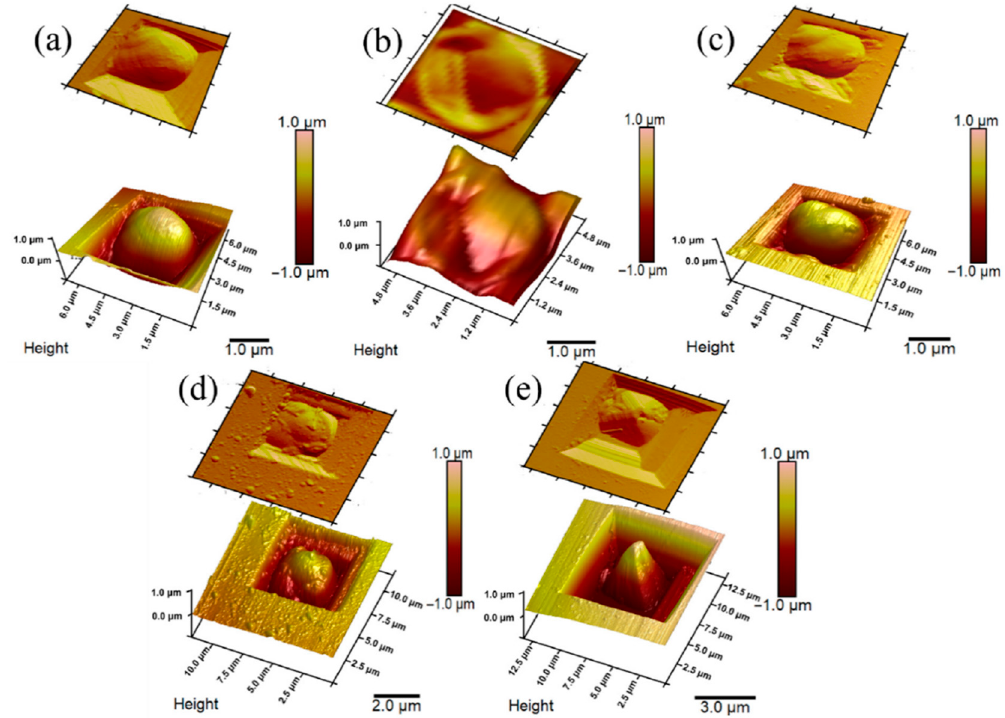
Figure 4. AFM images: ( a ) non-modified yeast cell; ( b ) inactivated yeast cell; ( c ) PPy0.05-modified yeast cell; ( d ) PPy0.1-modified yeast cell; ( e ) PPy0.3-modified yeast cell. Adapted from [46].